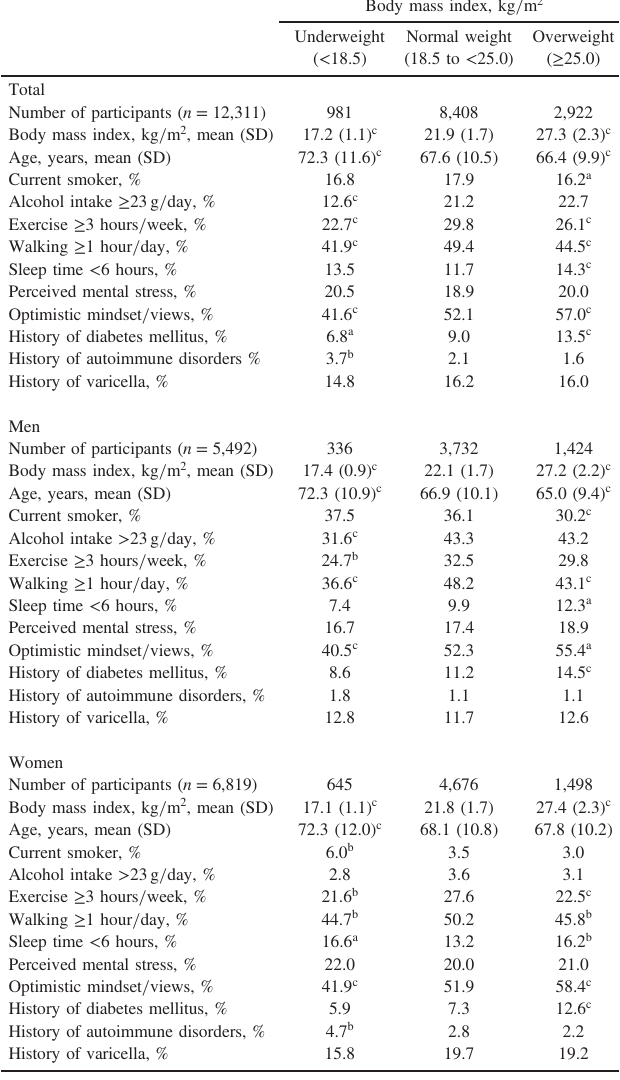
Table 1. Total and sex-speci fi c mean values and proportions of baseline characteristics by body mass index